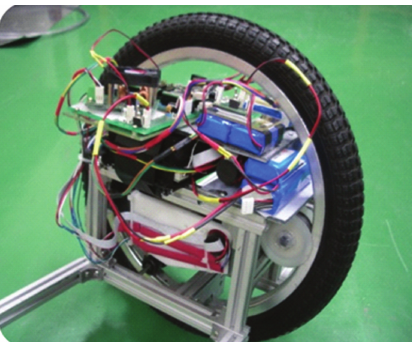
Figure 9: Real design of GYROBO